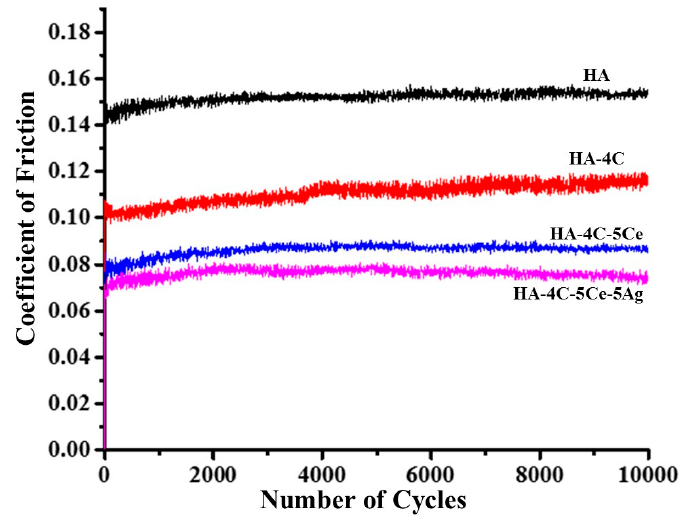
Figure 5. Plot representing coefficient of friction (COF) as a function of number of cycles during ball-on-disc of HA, HA-4C, HA-4C-5Ce, and HA-4C-5Ce-5Ag composites.